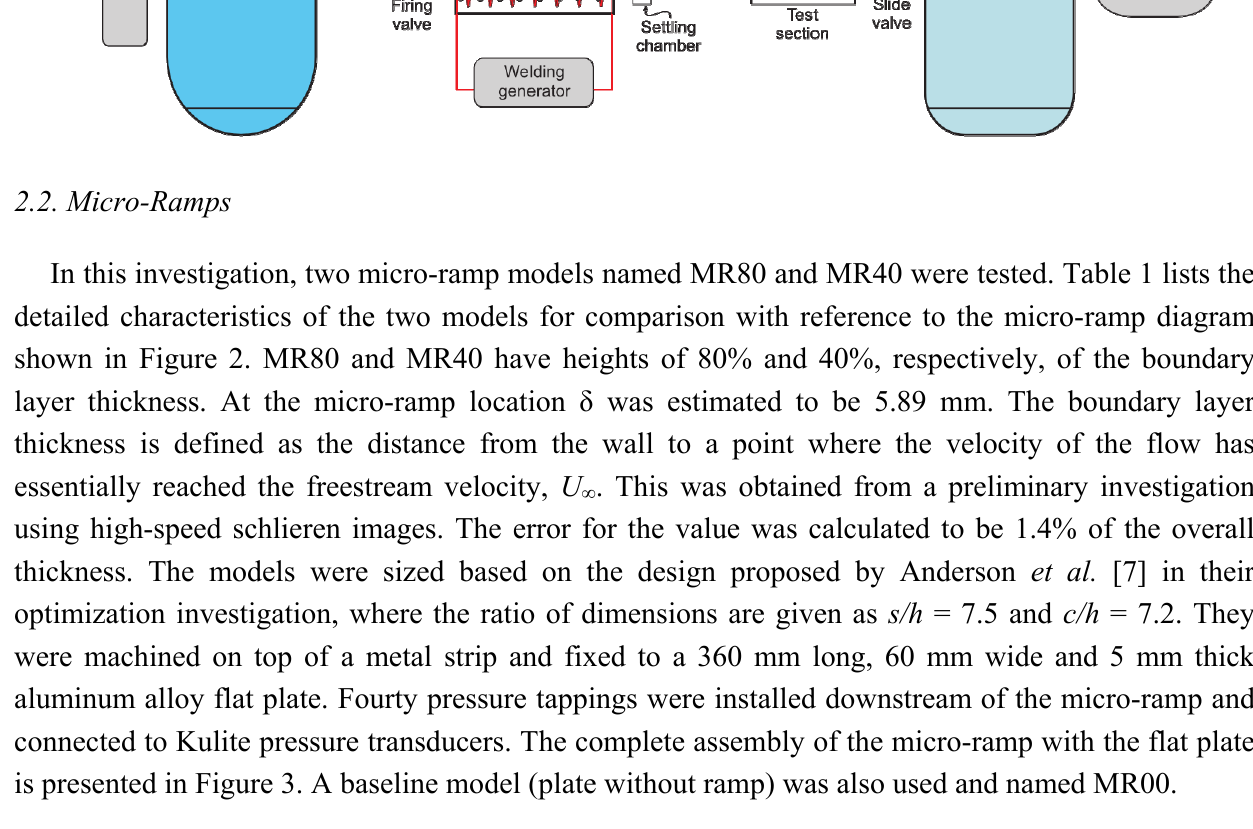
Table 1. Dimensions of MR80 and MR40 for